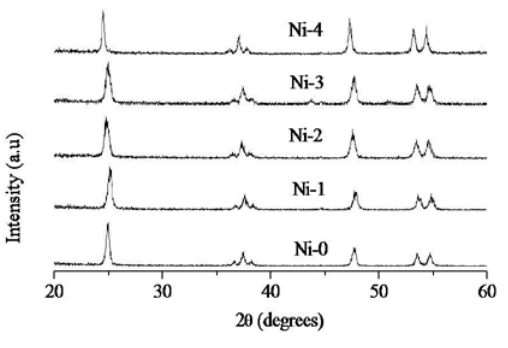
Figure 1. PXRD pattern of Ni 2+ -TiO